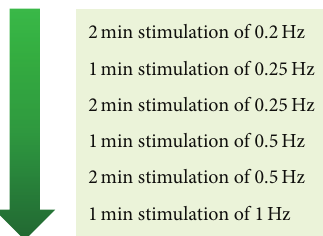
Figure 1: All investigated PAS 10 ms protocols. The order of the inves- tigation is following the direction of the arrow which begins with 2- minute stimulation of 0.2 Hz and finishes at 1-minute stimulation of 1Hz. Six different healthy volunteers were assigned to each protocol by the order of recruitment. We had to complete all 6 subjects in the same protocol before investigating the next protocol. Min = minute and PAS 10 ms = paired associative stimulation with interstimulus interval of